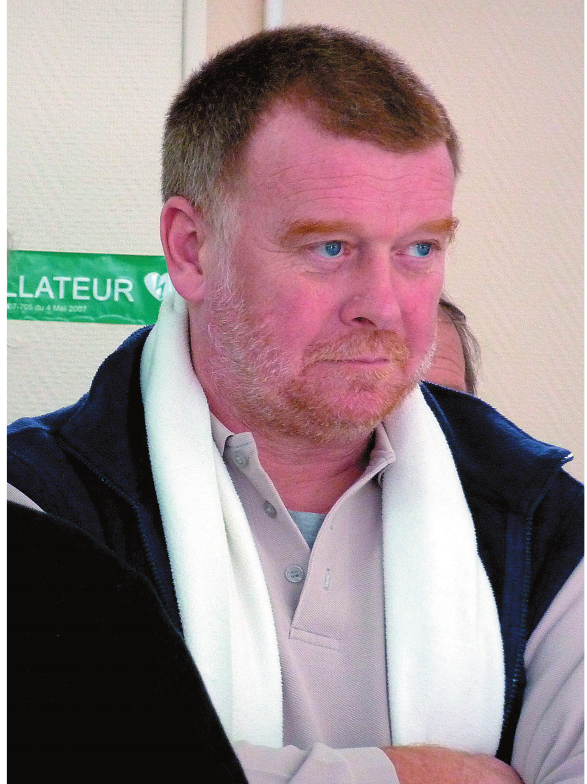
Fig. 1. Patrice Francour at Carry-Le-Rouet (France) in the occasion of the General Assembly of GEM (Groupe d’Etude du Mérou) in 2010; © J.G.